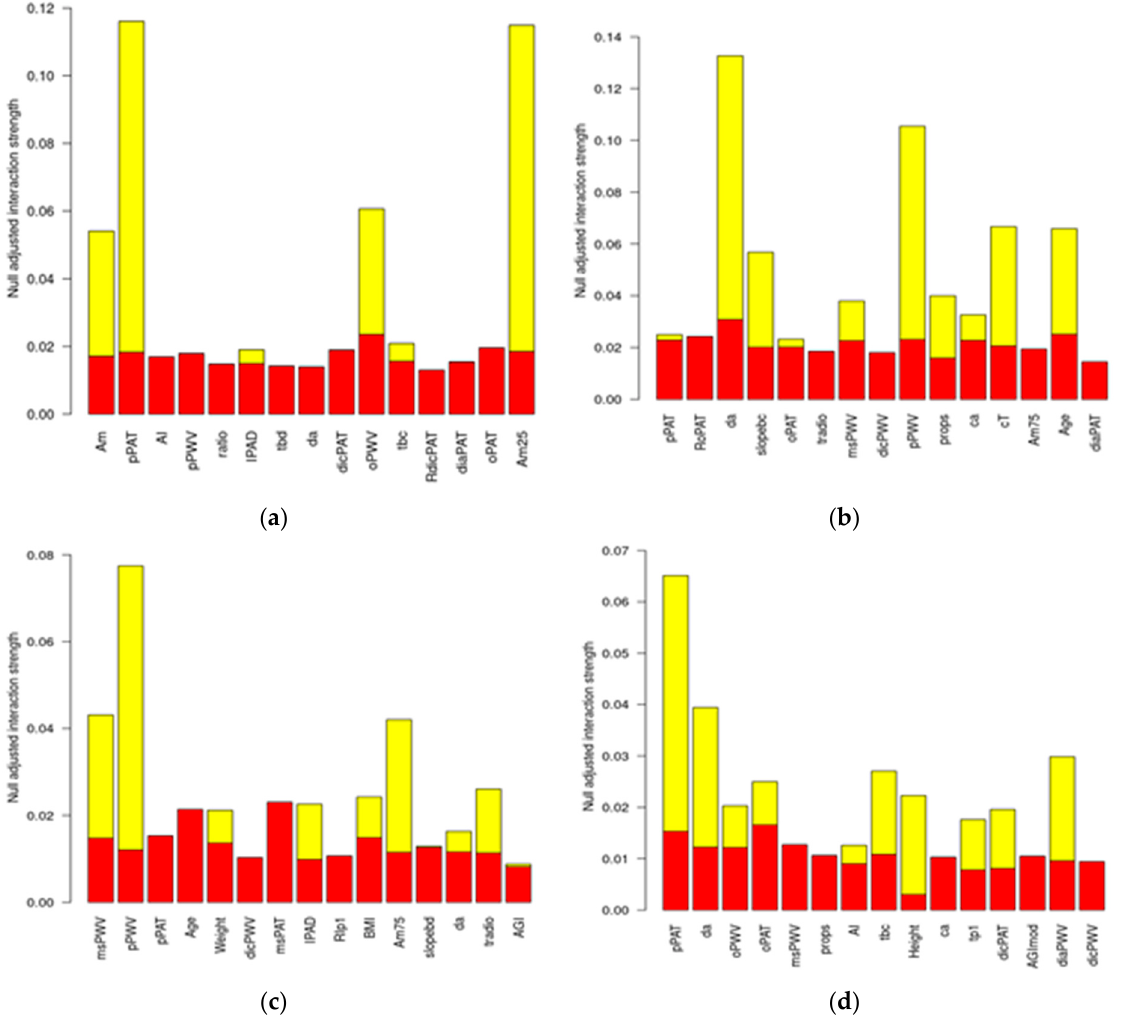
Figure 4. Interactions among variables. ( a ) DBP during rest; ( b ) DBP during the WBT; ( c ) SBP during rest; ( d ) SBP during the WBT.